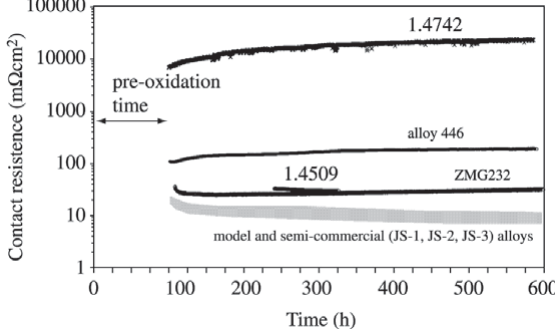
Figure 4. Contact resistance of commercial ferritic steels and FeCrMn(La/Ti) alloys (JS-1, JS-2, JS-3) at 800 °C in air.